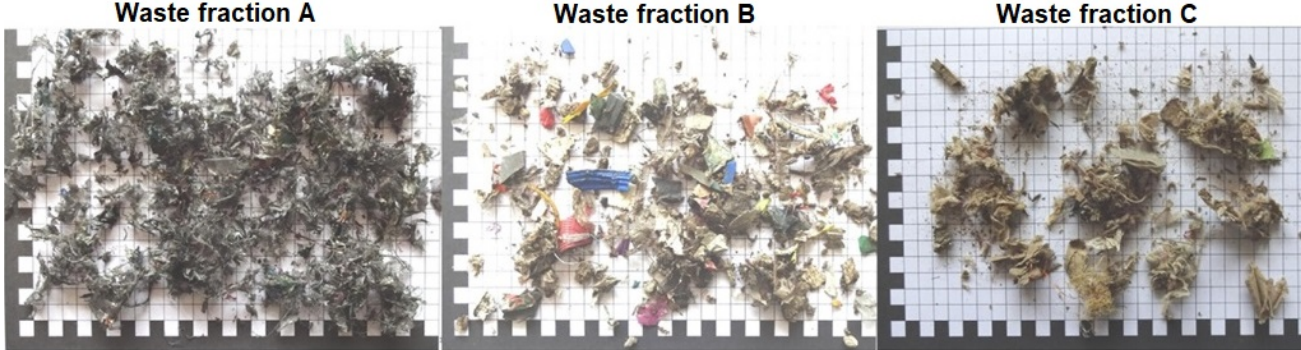
Figure 1. Waste fraction A, B, and C (left to right) [13] (Reproduced with permission from Schwabl D.; Proceedings of tenth “Recycling und Rohstoffe” Conference published by TK-Verlag, Berlin, 2017). Table 8. Parameters of representing feedstock samples for high (A), middle (B), and low (C) share of polyolefins [13]. Waste Frac- tion